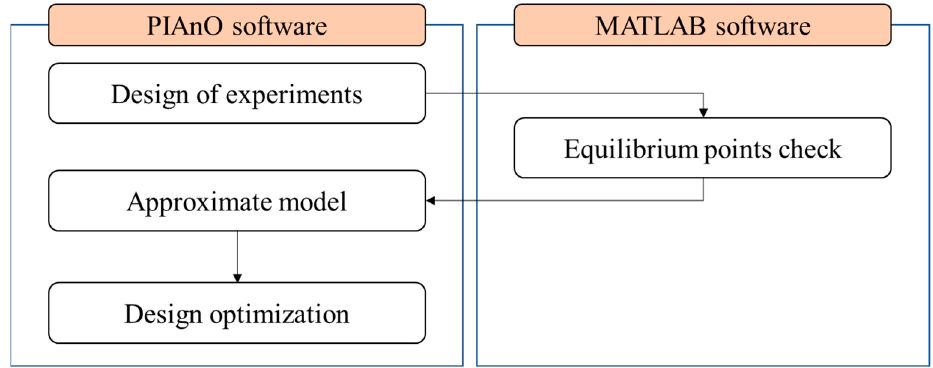
Figure 4. The analysis procedure.